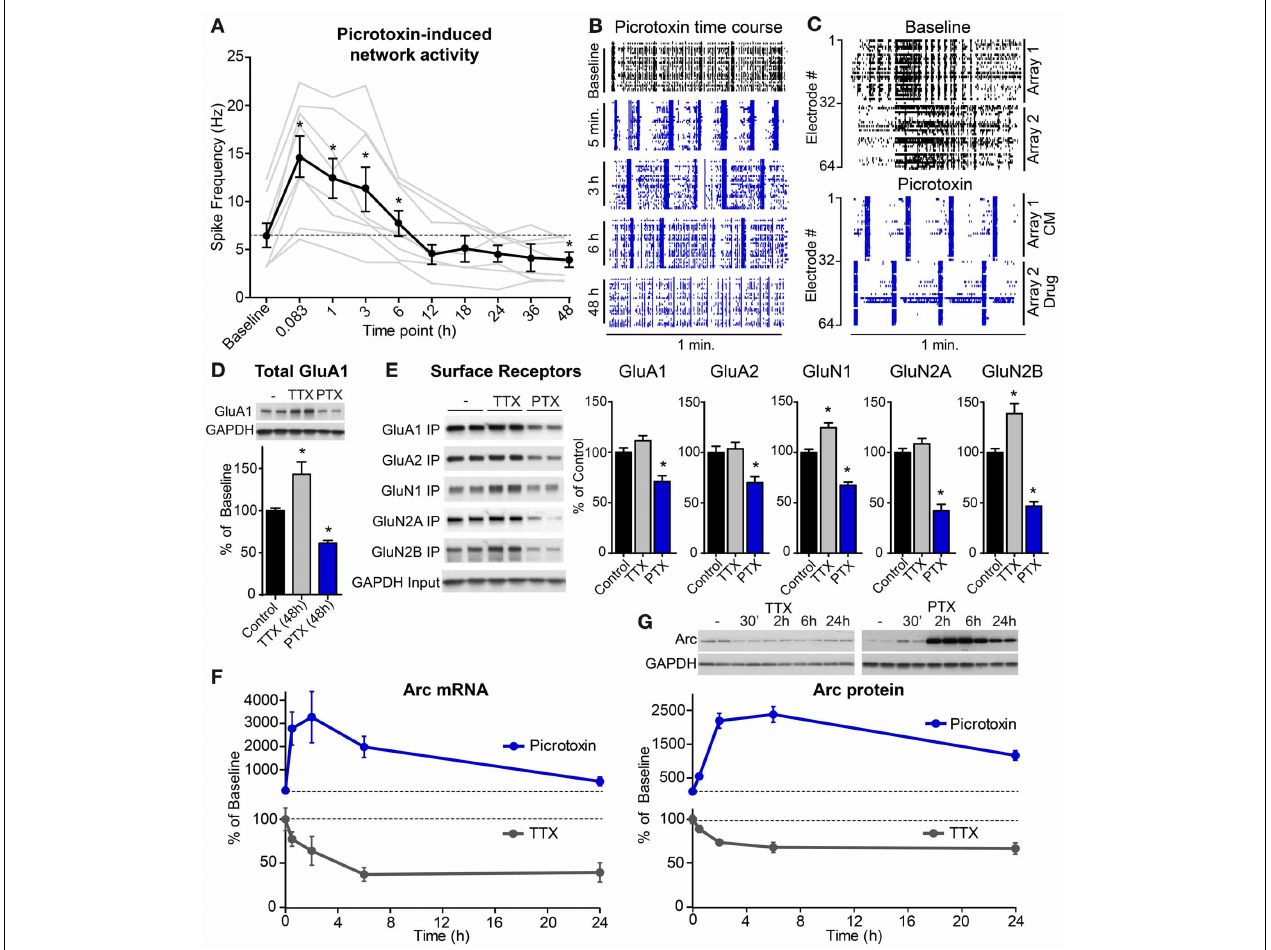
FIGURE 2 | High levels of network activity induce Arc mRNA and protein, down-scaling of glutamate receptors, and homeostatic plasticity of network spiking rates. (A) Average spike rate per electrode ( n = 8 experiments, plotted individually in gray) from hippocampal neurons plated onto multi-electrode arrays and treated with 0.5 μ M picrotoxin for the indicated durations in hours. (B) Raster plots of multi-unit activity recorded at different times following picrotoxin treatment. Each line represents a single spike detected in a given channel during a one minute recording. (C) Neurons were plated onto two sides of a split-chamber MEA and baseline activity was recorded from both cultures at DIV 14 (top panel). The neurons on electrodes #1–32 (Array 1) were then treated with conditioned media (CM) from another culture previously incubated with 1 μ M picrotoxin for six hours. The neurons on electrodes #33–64 (Array 2) were treated with 1 μ M freshly prepared picrotoxin (Drug). Spiking responses were recorded five minutes later (bottom panel). (D) Total levels of GluA1 protein normalized to